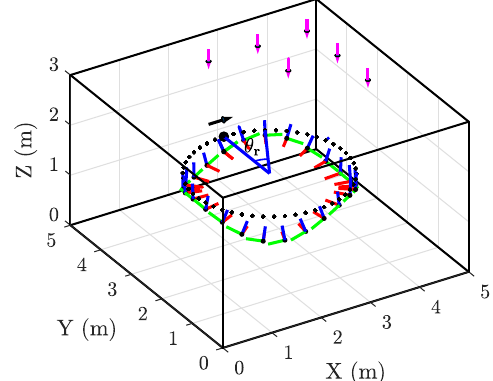
Figure 6. Simulation setup for the QADA receiver. The three orthonormal vectors in three different colors (the red, green, and blue vector represent the x -axis, y -axis, and z -axis, respectively) at each sample on the path represent the frame of the receiver. The pink arrows represent the LEDs (only a fraction of them are shown) on the ceiling. θ r indicates the traveled angle along the dotted circle in the XY